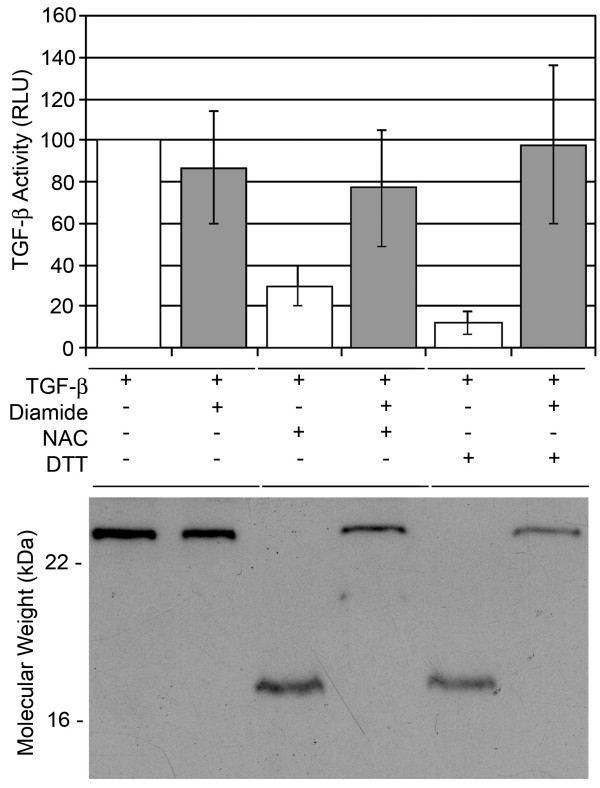
Activity of purified TGF-β NAC is dependent on Redox state. Purified active TGF-β (R&D Systems) was treated with either NAC or DTT as described, was then incubated in the absence or presence of 10 mM diamide for two hours at 37°C. Samples were dialyzed for two hours then either (A) incubated with TMLC cells to measured luciferase production or (B) separated by polyacrylamide gel electrophoresis and subjected to western blot analysis TGF-β. Data represents percent of control ± standard error where control is TGF-β sample untreated (p < 0.05 for NAC 2 mM and 10 mM versus TGF-β alone). Diamide restored activity levels to that of TGF-β alone (p > 0.05 of TGF-β alone versus TGF-β + NAC (20 mM) or TGF-β + DTT (10 mM) + diamide). Recombinant human TGF-β migrated as a ~25 kD protein that was reduced to a ~12.5 kD protein by the addition of NAC or DTT. Data shown in (B) is a representative of six independent experiments.